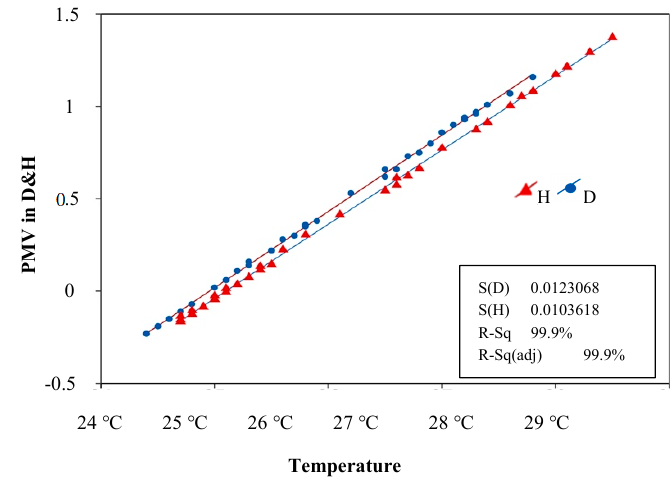
Figure 14. Fitted relationship between temperature and predicted mean vote (PMV) in Heyang (H) and Danzhi (D).